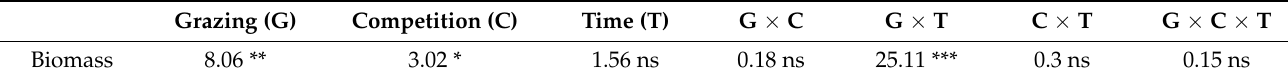
Table 1. Statistical effects of grazing and competition on clone biomass. F values and significance levels (* p < 0.05; ** p < 0.01; *** p < 0.001; ns not significant, p > 0.05) are given. Degrees of freedom are (1, 16). A significant grazing by competition by time interaction (G × C × T) would indicate